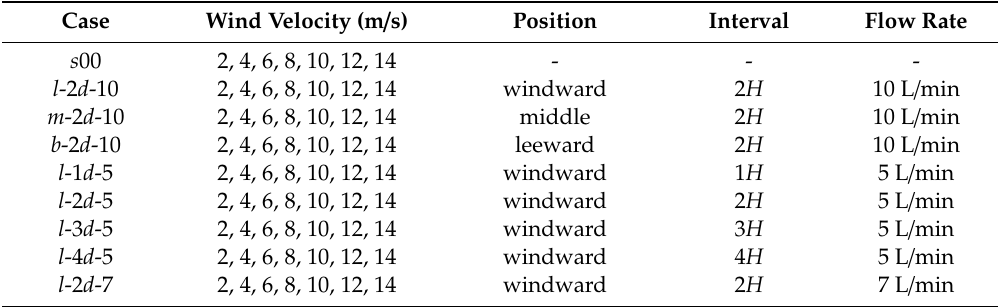
Table 1. Test cases for flutter performance of section model with various control parameters.